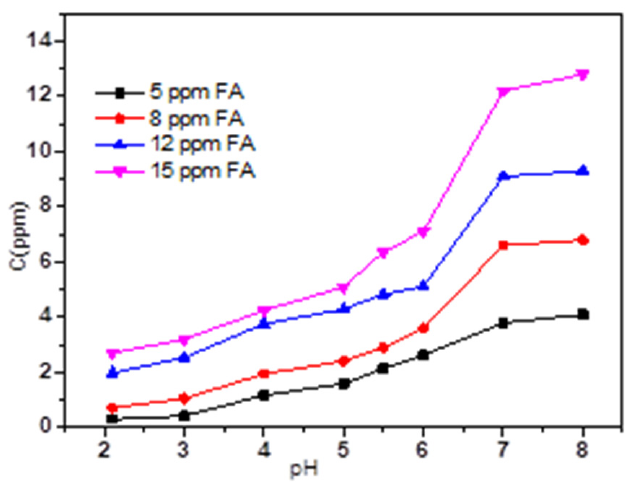
Figure 6. Effect of FA in different concentrations on TC adsorption by magnetic sludge biochar (adsorption time: 18 h).